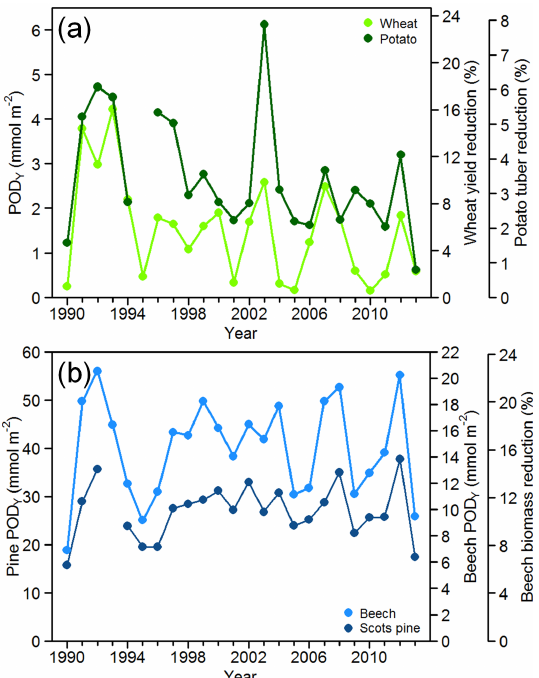
Figure 8. Impact of O 3 characterised by the POD Y metric (and associated response) for (a) wheat (grain yield reduction), potato (tuber weight reduction), (b) beech (biomass reduction) and Scots pine at Harwell between 1990 and 2013.